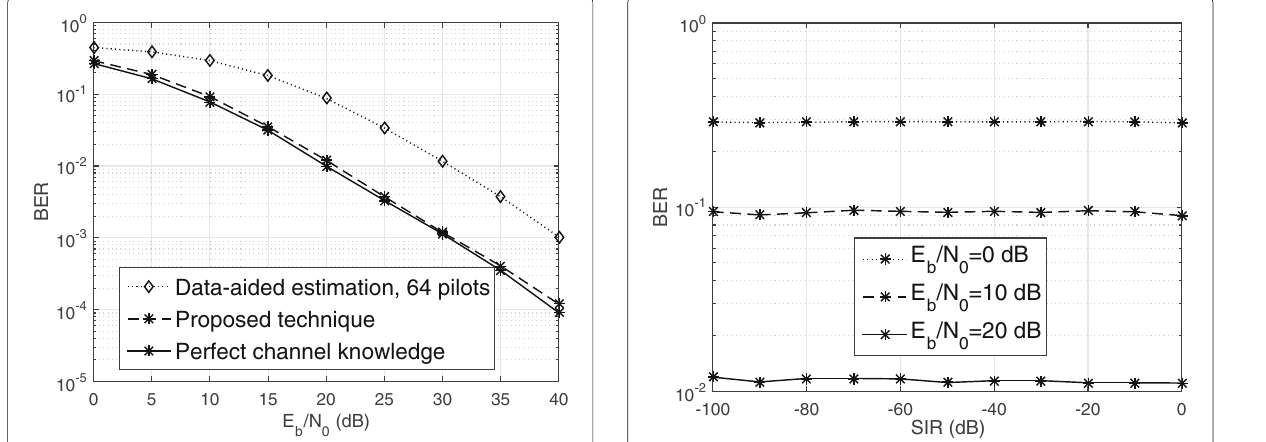
analog cancellation requiring digital SI cancellation